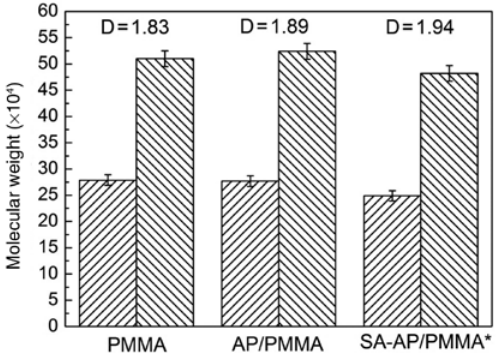
Figure 6: Molecular weight of polymer and composites.